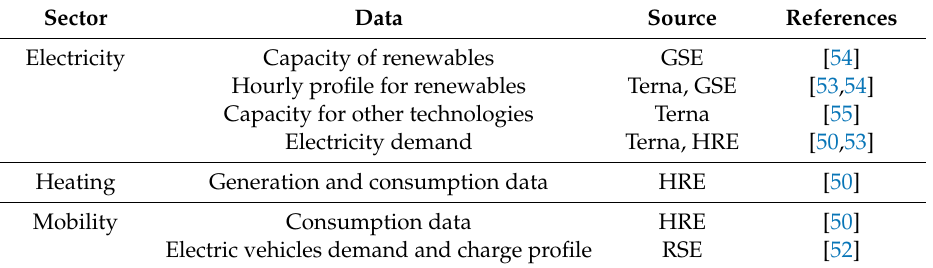
Table 1. Sources used for the development of the 2015 baseline for